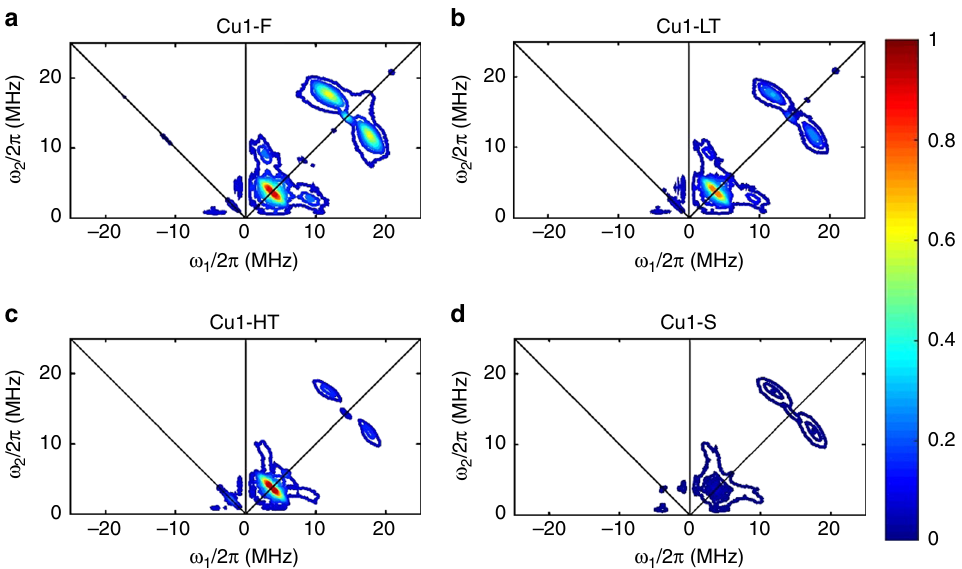
Fig. 3 HYSCORE spectra for hydrated Cu1 samples. a Cu1-F; b Cu1-LT; c Cu1-HT; d Cu1-S. The four spectra have undergone normalization to signal intensity/videogain/mass, using the same color scale and contour level for the purpose of direct